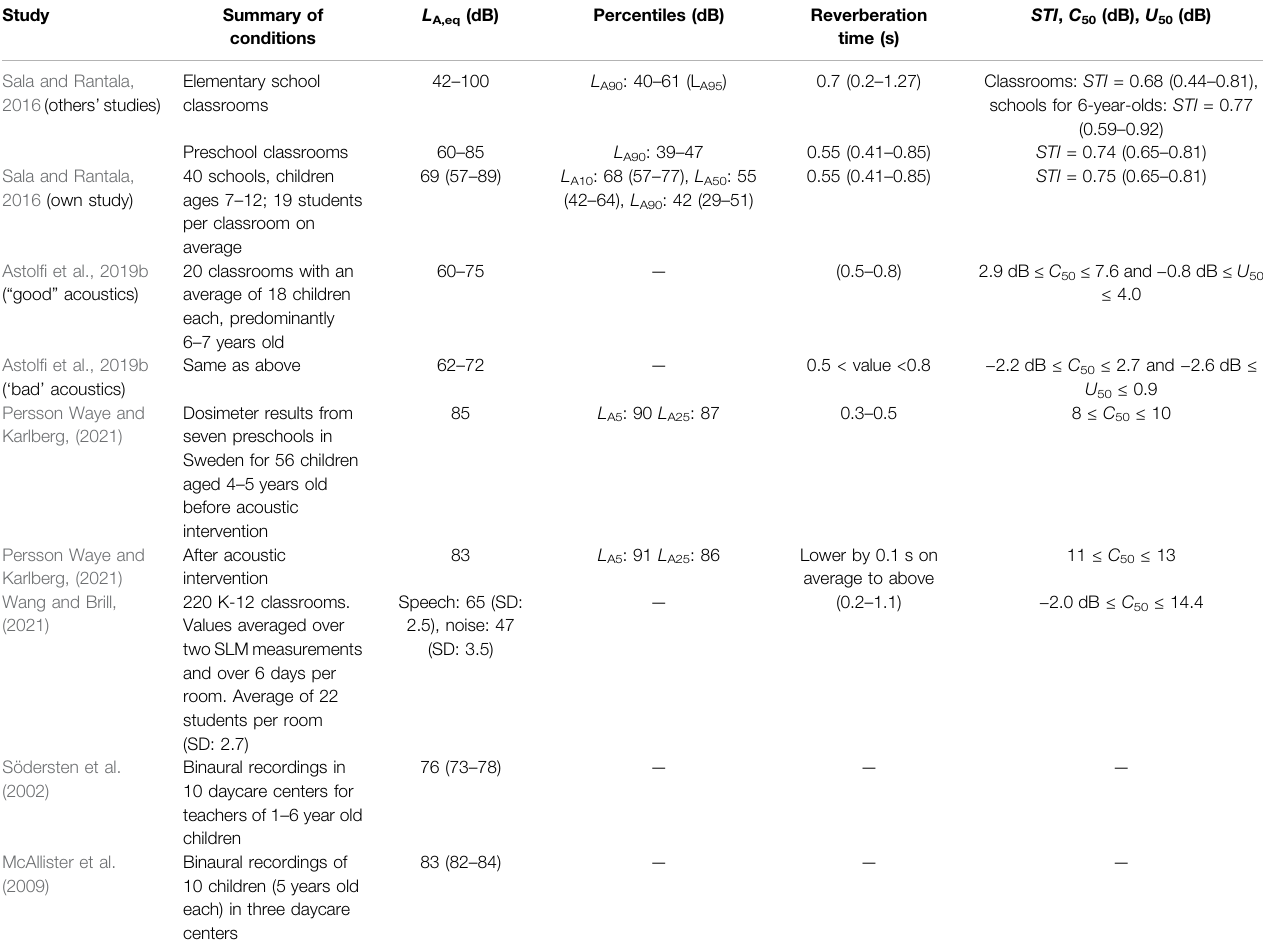
TABLE 1 | Summary of noise and room acoustic parameters in previous studies. Reported values are mean and the range (in brackets) unless indicated